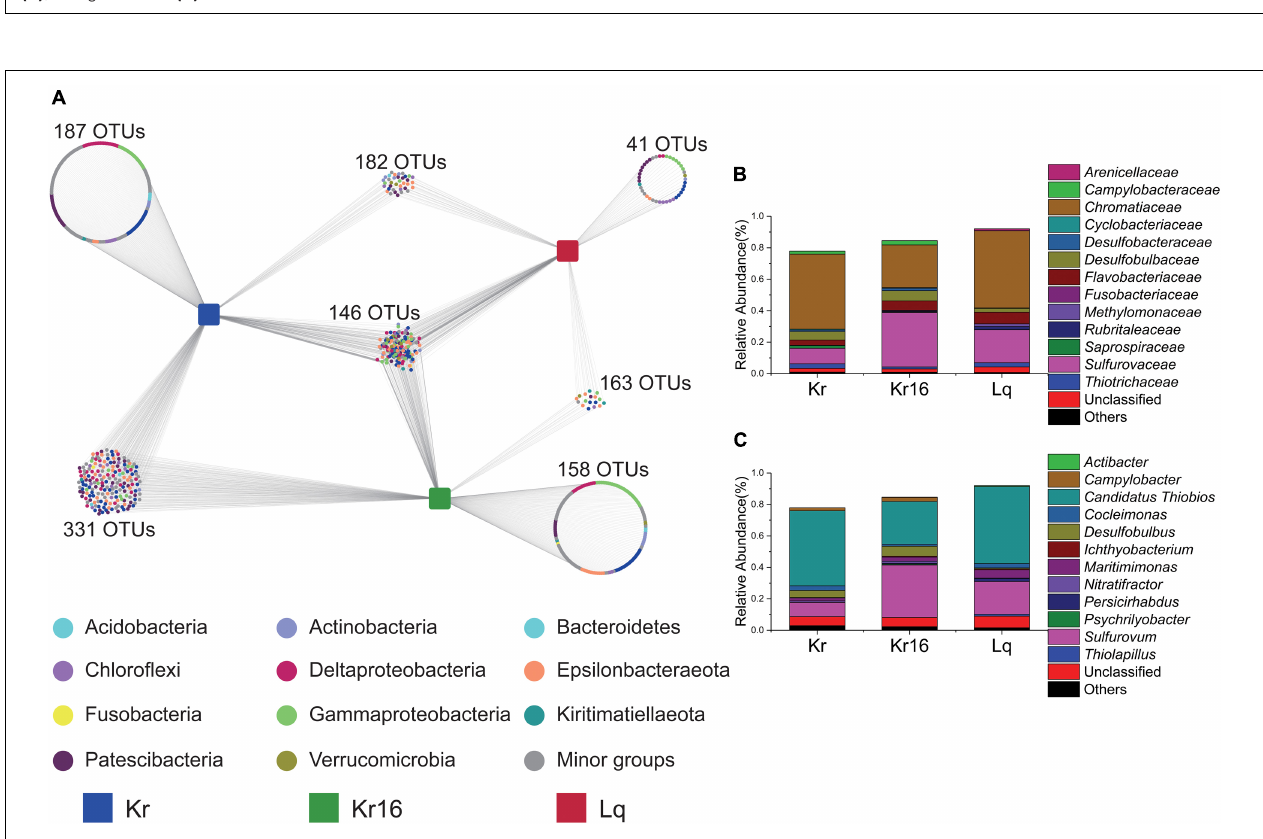
FIGURE 4 | Distribution of OTUs in the samples of Kr, Kr16, and Lq (A) , and the stacked bar chart showing the relative abundance of the microbial communities consisting of the shared OTUs from all samples at the level of family (B) , and genus (C) . Kr refers to SFS samples collected from the Kairei vent field; Kr16 refers to SFS samples collected from the Kairei vent field, and reared for 16 days; Lq refers to SFS samples collected from the Longqi vent field.